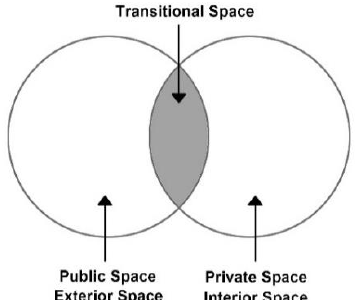
Figure 1. The transitional space is a buffer zone between the indoor space and the outdoor space.